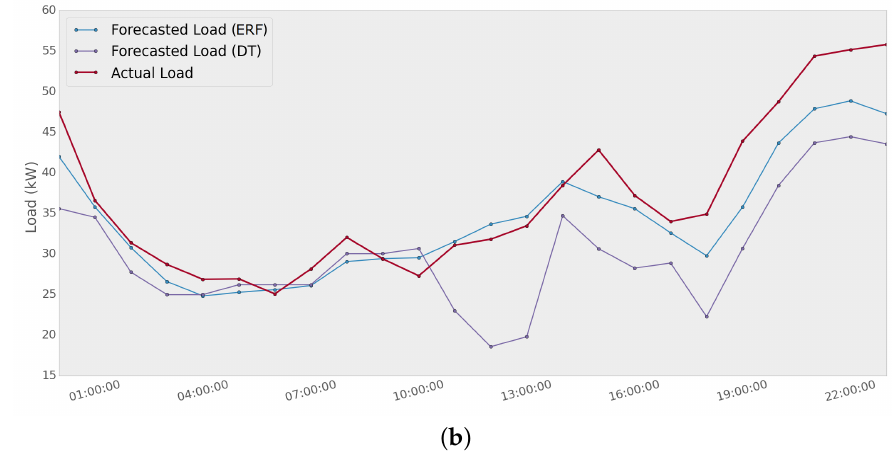
Figure 11. Comparison between methods ERF and DT for two different days: ( a ) 17 November 2014 and ( b ) 3 December